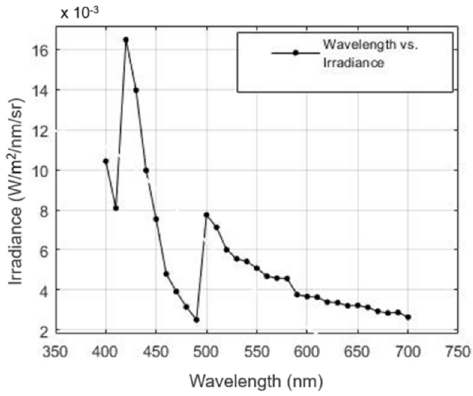
Figure 8. SDS limits of different working wavelengths of the USI system.